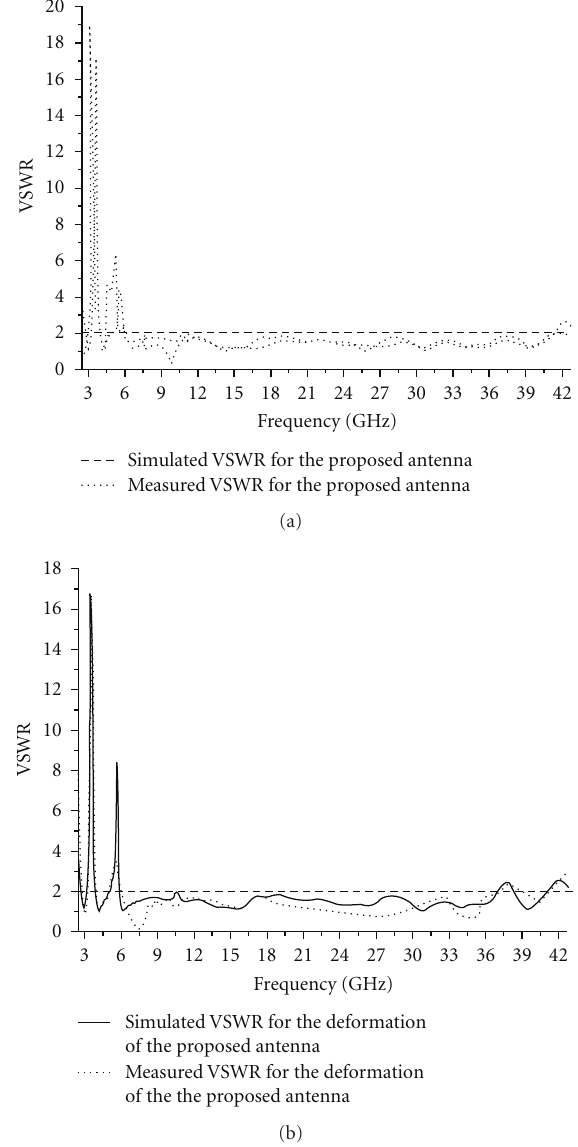
Figure 7: Simulated and measured VSWR results of the proposed antennas: (a) dual band-notched antenna 1, (b) dual band-notched antenna